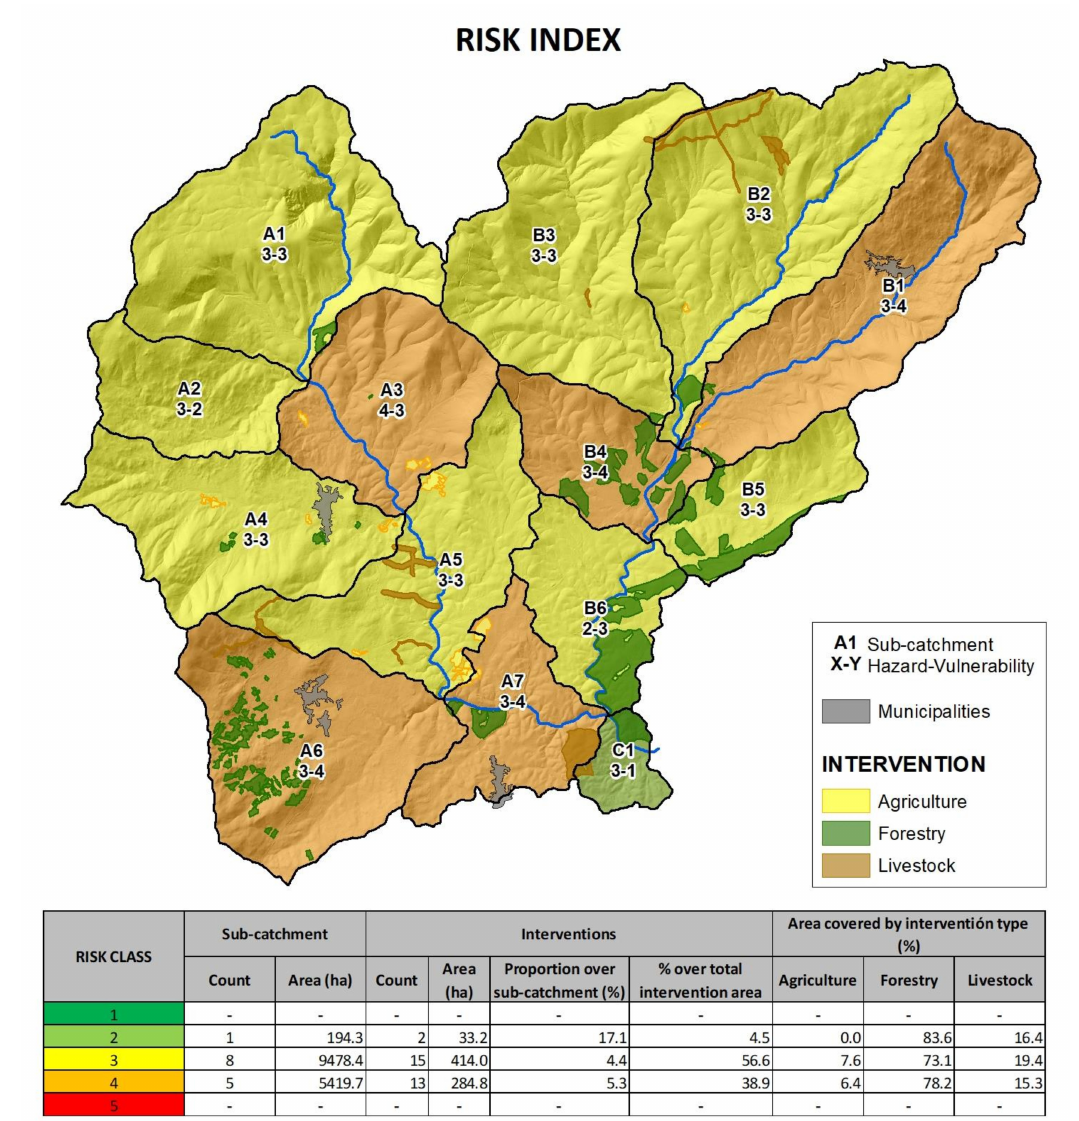
Figure 5. Final risk index by sub-catchment at the study site. Most interventions (15 out of 23) were located in sub-catchments with fire risk class 3, covering 414 ha (4.4% of the total area of these sub-catchments). Forestry covered 73%, livestock 19%, and agriculture 8% of the total intervention area. The largest intervention areas were found in sub-catchments B5 and B6, where forestry interventions covered around 20% of the sub-catchment’s area. Around 15.7% of the total intervention area (110 ha) was found in sub-catchments A5 and B2, in which agricultural and livestock interventions predominated. Sub-catchments with the highest fire risk index (class 4) included 13 interventions, covering 285 ha and 5.3% of the total area of these sub-catchments. Forestry covered 78%, livestock 15%, and agriculture 6% of the total intervention area. The largest intervention areas were found in sub-catchments A6, A7, and B4. Forestry interventions covered 15.4% of the area of sub-catchment B4. Finally, sub-catchment C1 was the only one with risk class 2, with two interventions (forestry and livestock) covering 33 ha (17% of the area of the sub-catchment) (Table